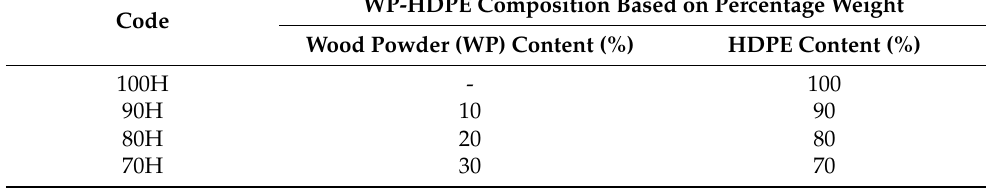
Table 4. WP-HDPE